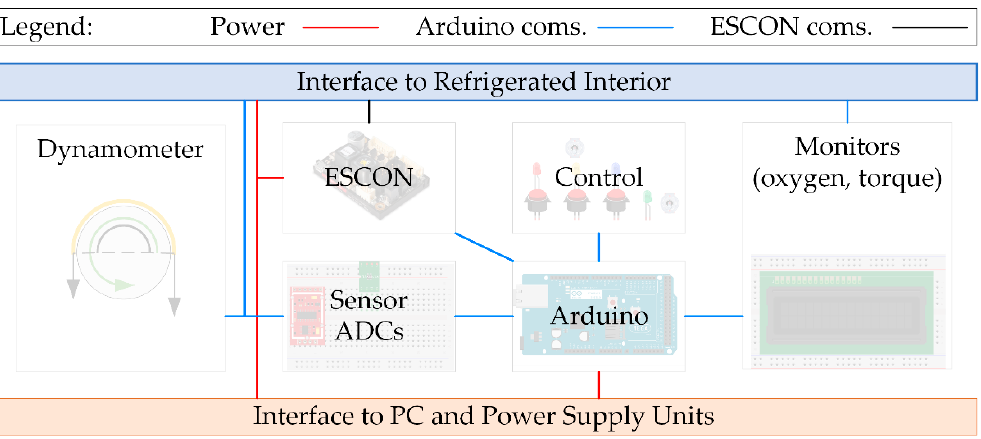
Figure 3. Layout of electronic system.